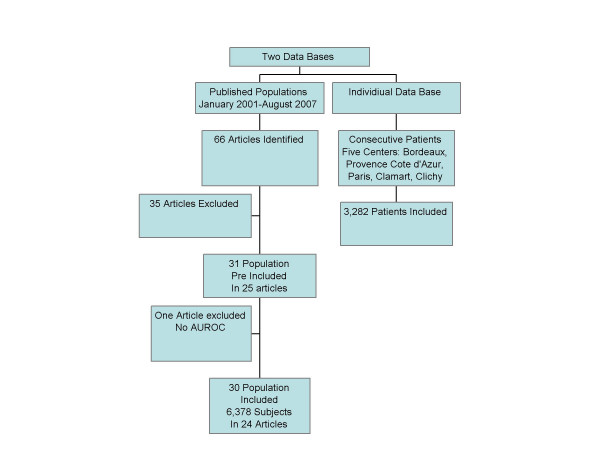
Flow sheet of the included databases.